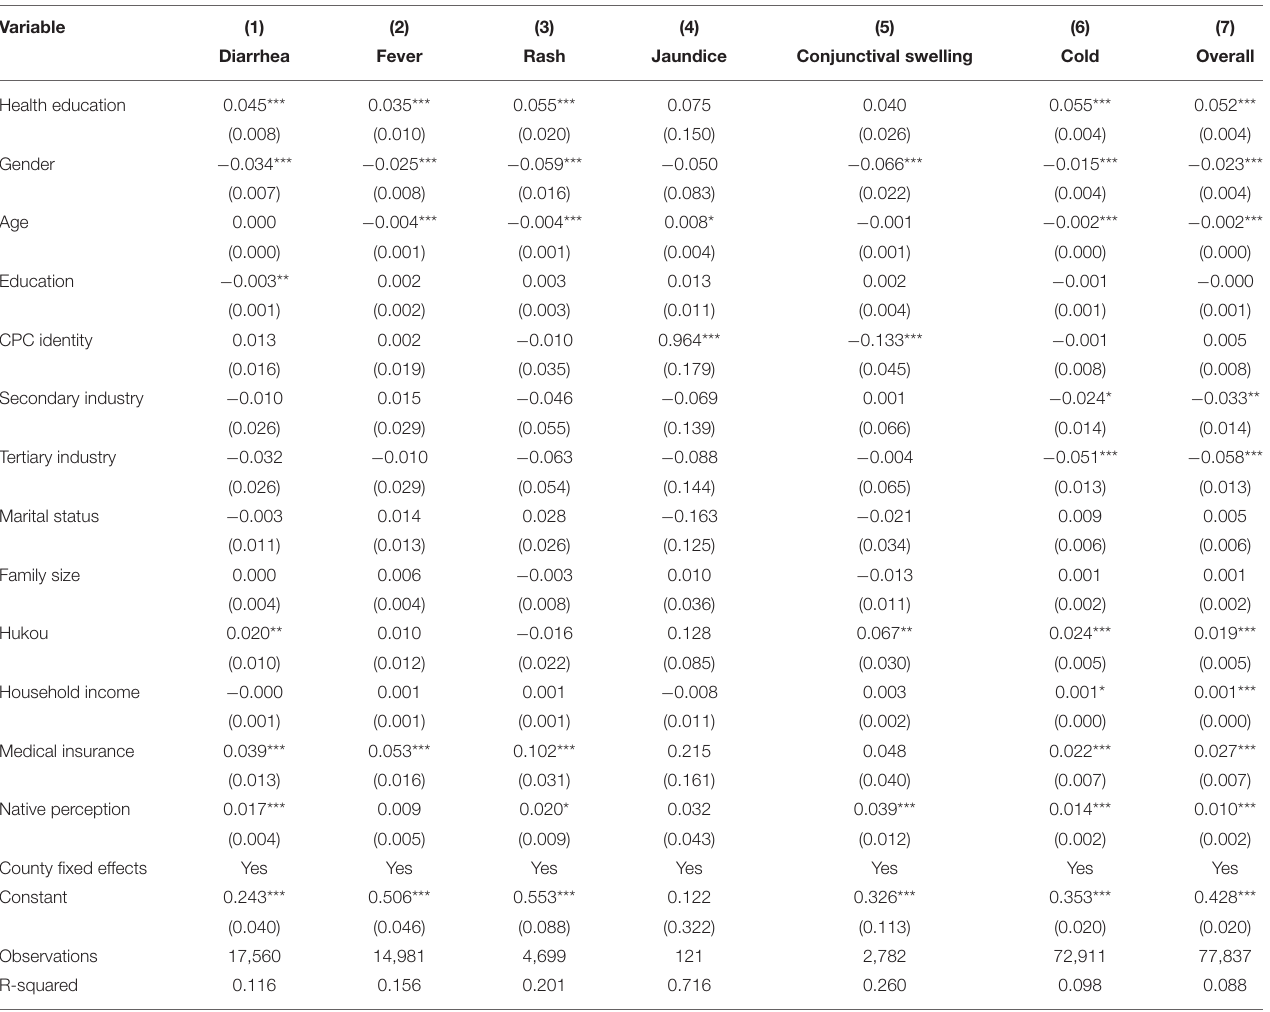
TABLE 3 | The effect of health education on medical service utilization of the migrants.